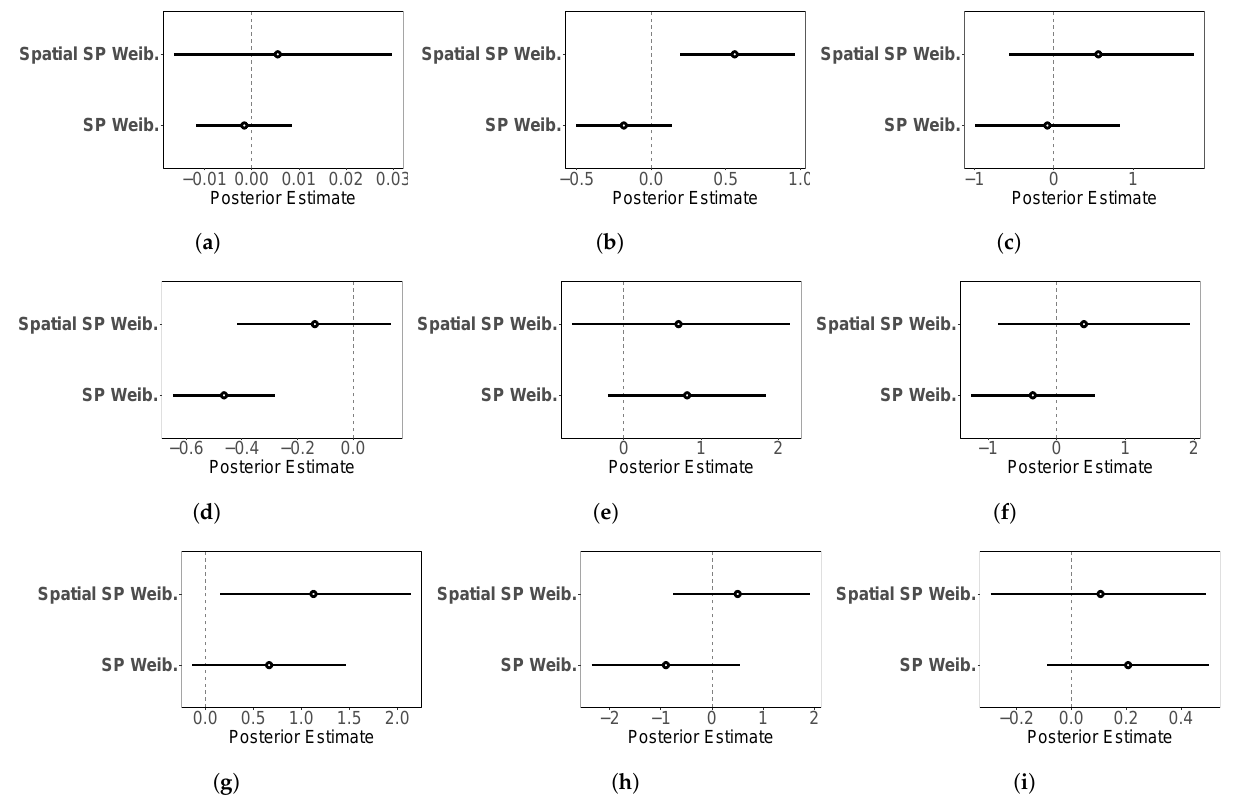
Figure 9. Peace survival stage ( ˆ β ) coefficient results from SP Weibull and Spatial SP Weibull models for the following covariates: ( a ) press freedom, ( b ) GDP/cap, ( c ) peace agreement, ( d ) intensity, ( e ) ethnic factionalization, ( f ) UN peacekeeping, ( g ) territory, ( h ) non-contiguous, and ( i )